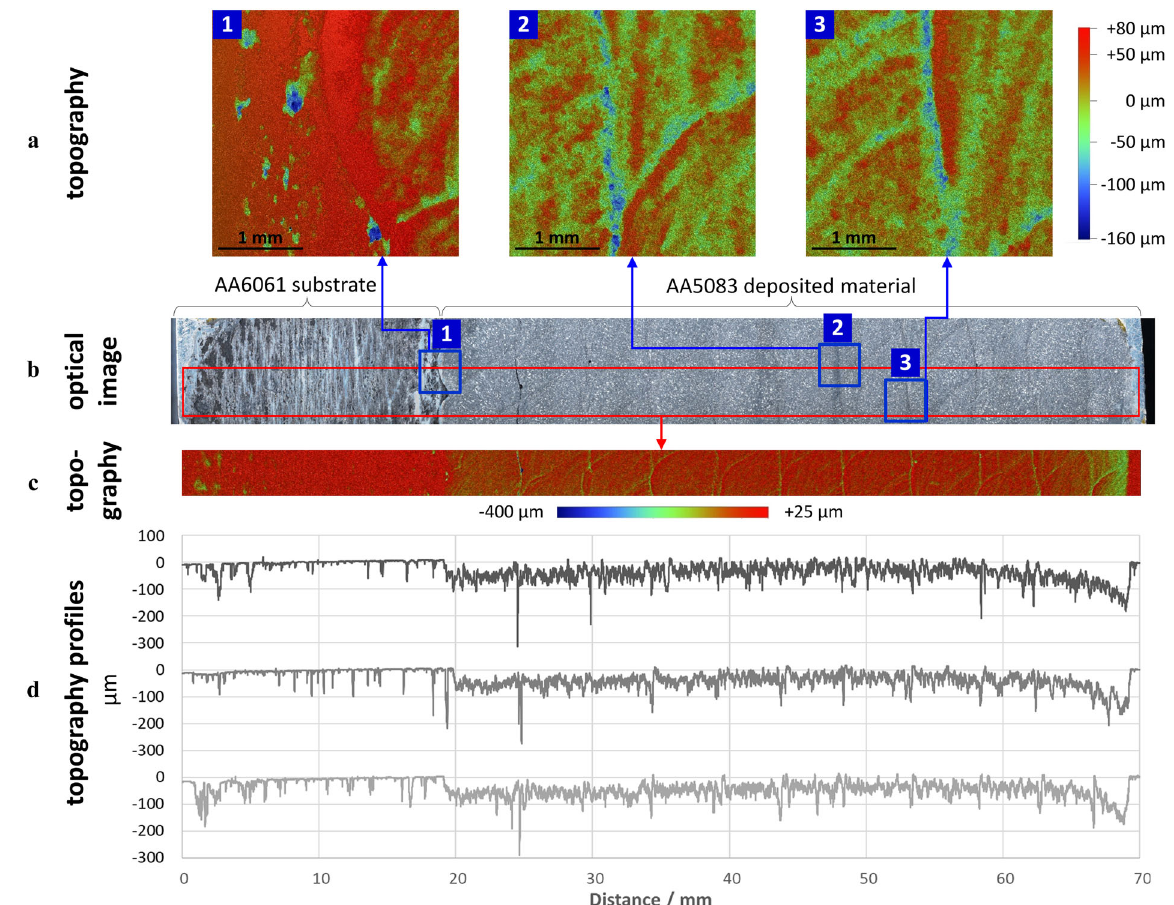
Fig. 9 Topography mapping results of the corroded sample. a High-resolution map of the transition between substrate and deposited layers (left) and of two-layer interfaces; b , c Optical image with the positions of the topography measurements and topography mapping over the whole length of the sample; d Three topography pro fi les extracted from the large area